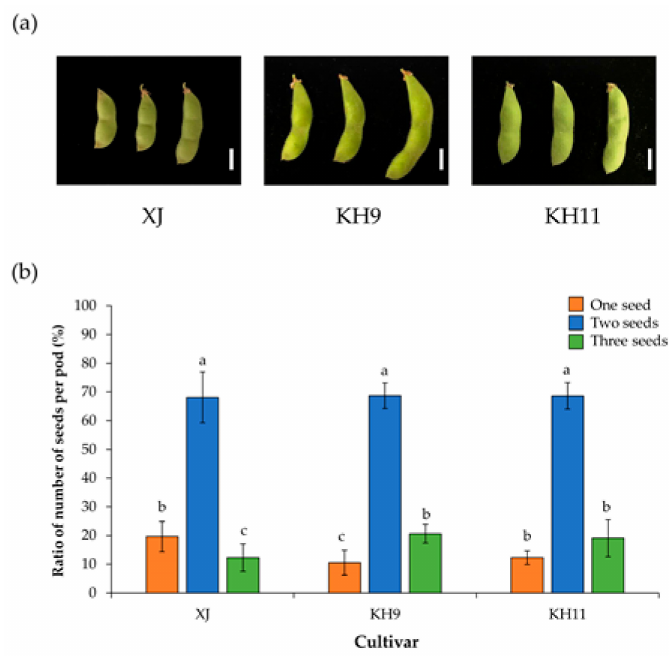
Figure 3. Pod phenotypes and the ratio of the number of seeds per pod of XJ, KH9, and KH11. ( a ) Phenotypes of pods of XJ, KH9, and KH11. ( b ) Number of seeds per pod of XJ, KH9, and KH11. Bar = 1 cm. Values represent the mean ± SD of three biologically independent experiments. Different letters indicate significant differences between cultivars assessed using the LSD post hoc test ( p < 0.05). XJ, Xiang-Ji. KH9, Kaohsiung No. 9. KH11, Kaohsiung No.